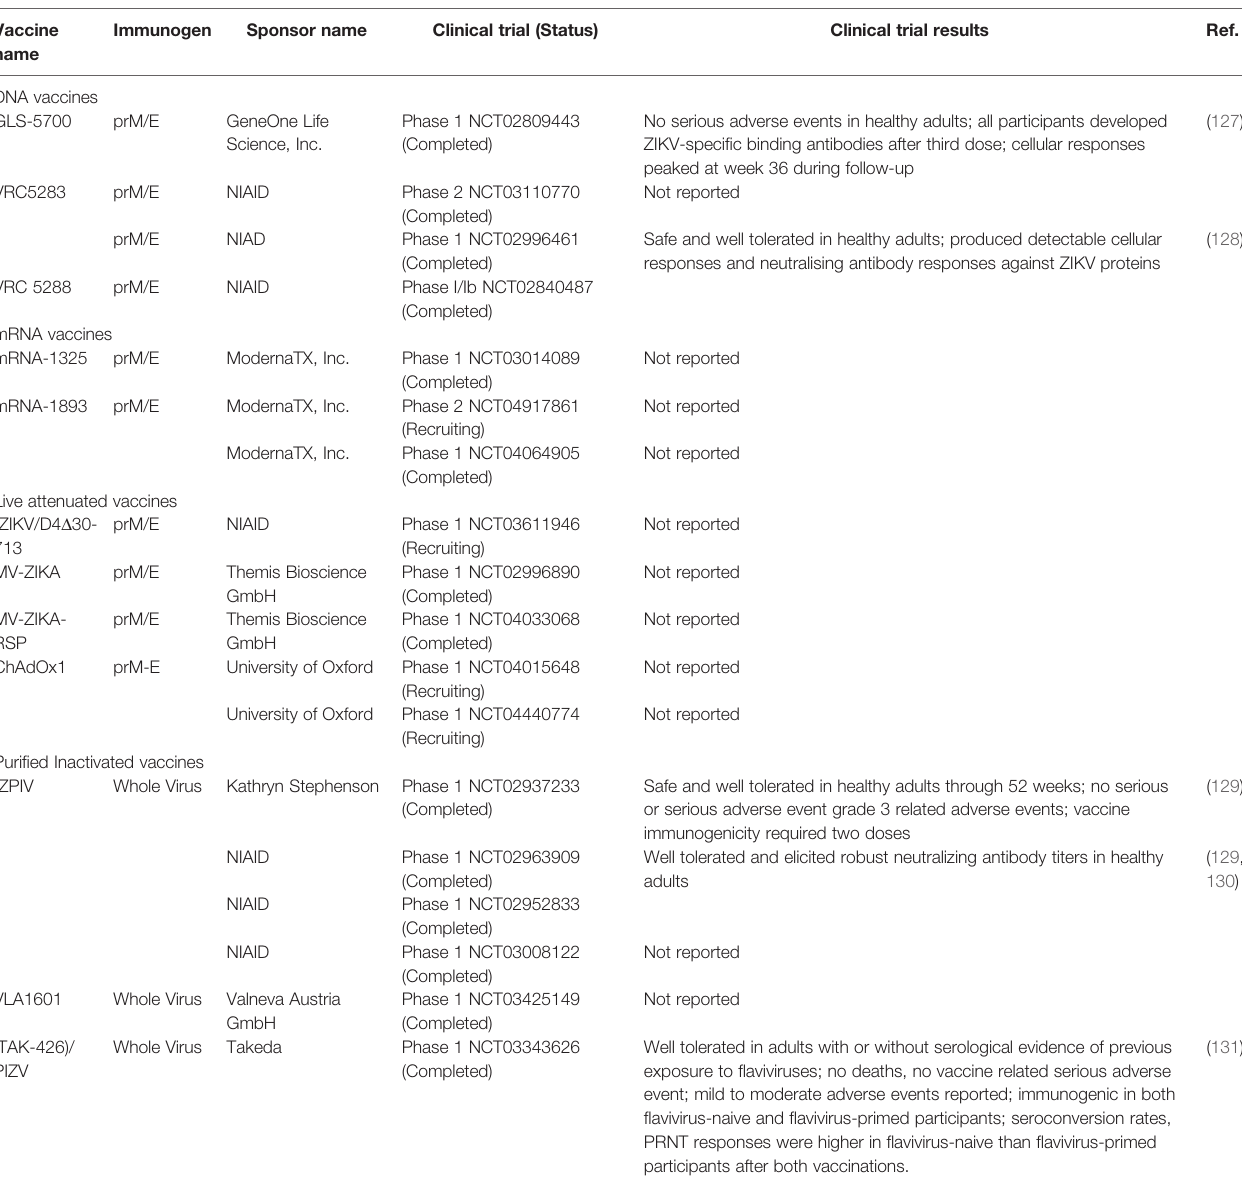
TABLE 1 | Zika vaccine candidates in clinical